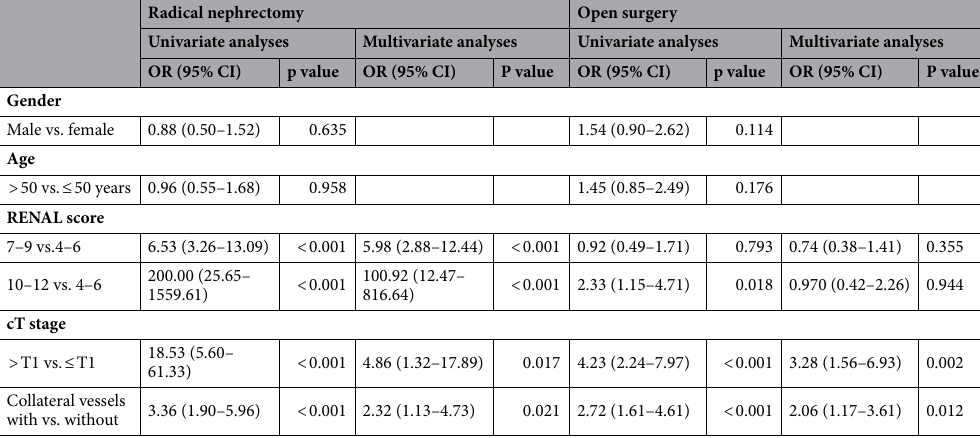
Table 6. Univariate and multivariate analyses of different clinicopathological factors in predicting radical nephrectomy and open surgery.